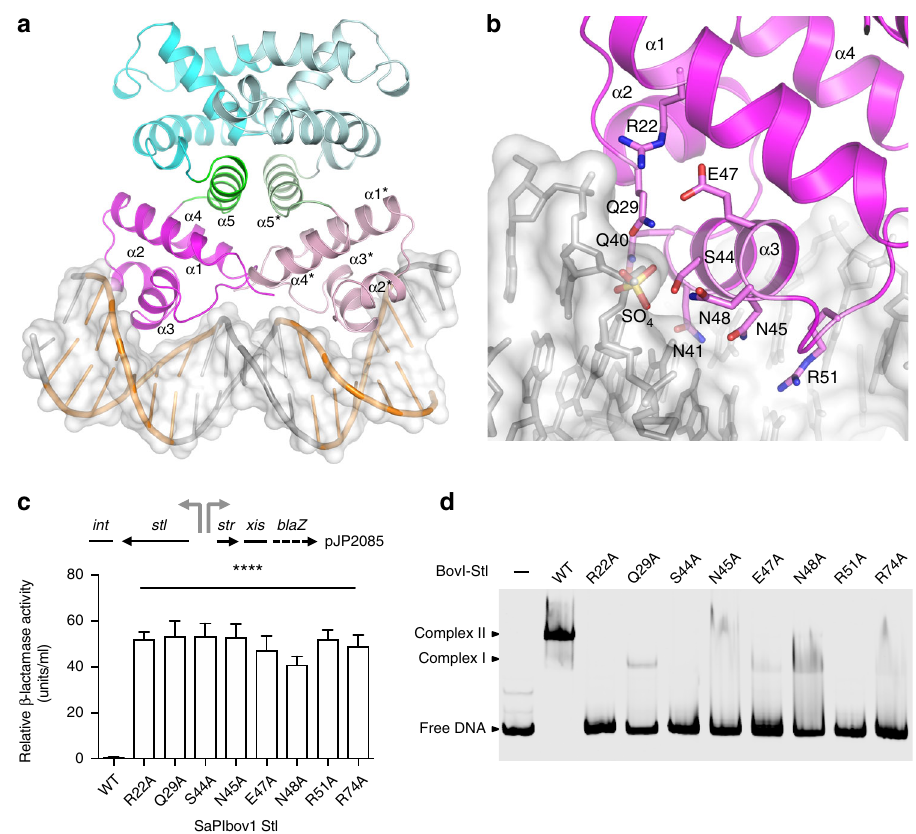
Fig. 2 Structural and functional analysis of the DNA-binding model of the Stl dimer. a Model of dimeric Stl bound to the palindromic SaPIbov1 repression site. The BovI-Stl N-ter dimer is presented in cartoon representation with one protomer coloured as in Fig. 1b and the other with lighter tones. DNA is shown in grey sticks and white surface with the TATCTC palindromic sequences highlighted in orange. Binding of the dimer is based on the superimposition of individual BovI-Stl N-ter protomers with the C.Esp1396I complex and its palindromic DNA operator (PDB:3CLC 41 ; Supplementary Fig. 2b). Structural elements of the HTH DNA-binding domain and the connector helix are labelled. b Close view of the modelled HTH-DNA interaction. Stl DNA interaction residues are highlighted in stick, coloured by atom type and labelled. The sulfate ion that is presented in the BovI-Stl N-ter structure is also shown in stick and labelled, and superimposes on a DNA backbone phosphate. The HTH α -helices are labelled. c Unregulated str transcription due to SaPIbov1 Stl repressor DNA- binding domain mutations. Top left: schematic of a blaZ transcriptional fusion in pJP2085. β -Lactamase assays were performed with RN4220 containing the pJP2085 SaPIbov1 Stl WT or derivatives, with data from three independent experiments. Error bars represent SD. ANOVA with Tukey ’ s multiple comparisons test compared mean differences between the Stl WT control and the mutants. Signi fi cant adjusted p values relative to the WT were: Stl R22A < 0.0001 **** ; Stl Q29A < 0.0001 **** ; Stl S44A < 0.0001 ****; Stl N45A < 0.0001 **** ; Stl E47A < 0.0001 **** ; Stl N48A < 0.0001 **** ; Stl R51A < 0.0001 **** ; Stl R74A < 0.0001 **** . d In vitro evaluation of mutations in the Stl DNA-binding domain. EMSA gel results of Stl WT and mutants in the residues predicted to interact with DNA in the model of panel b . In the presence of Stl WT the band corresponding to the stl - str DNA operator region, labelled as free DNA, disappears and two new bands corresponding to Stl-DNA complexes are observed (labelled as complex I and II; see ref. 21 ). For the Stl mutants the bands corresponding to Stl-DNA complexes almost completely disappear while most of the DNA appears at the lower position of the gel as free DNA. One representative experiment of at least three independent replicates is shown. Source data are provided as a Source Data fi